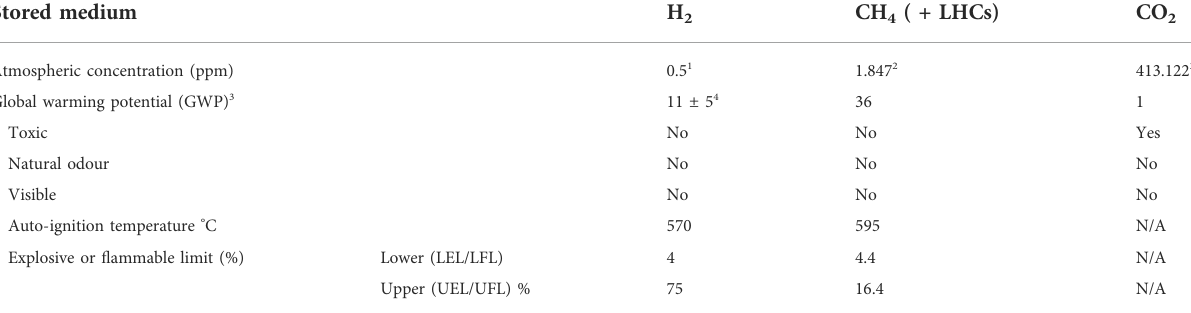
TABLE 2 Summary of the different properties of H 2 , CH 4, and CO 2 . Natural gas is normally a blend of light hydrocarbons (LHCs) but is predominantly CH 4 . 1 Pidwirny (2012), 2 Cape Grim Data (2022); 3 IPCC (2013); 4 Warwick et al.